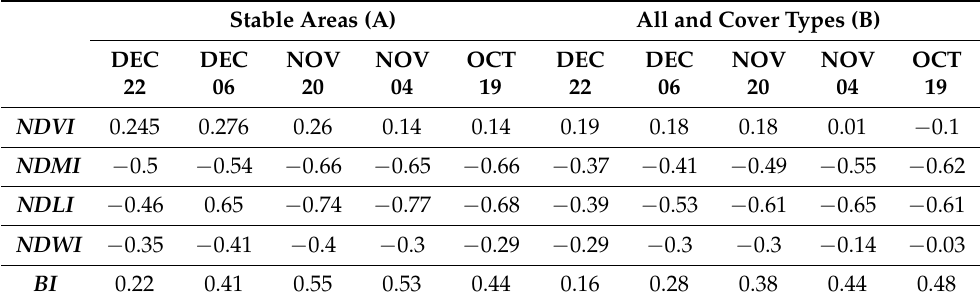
Table 2. Correlation between near-surface thermal and biophysical land surface